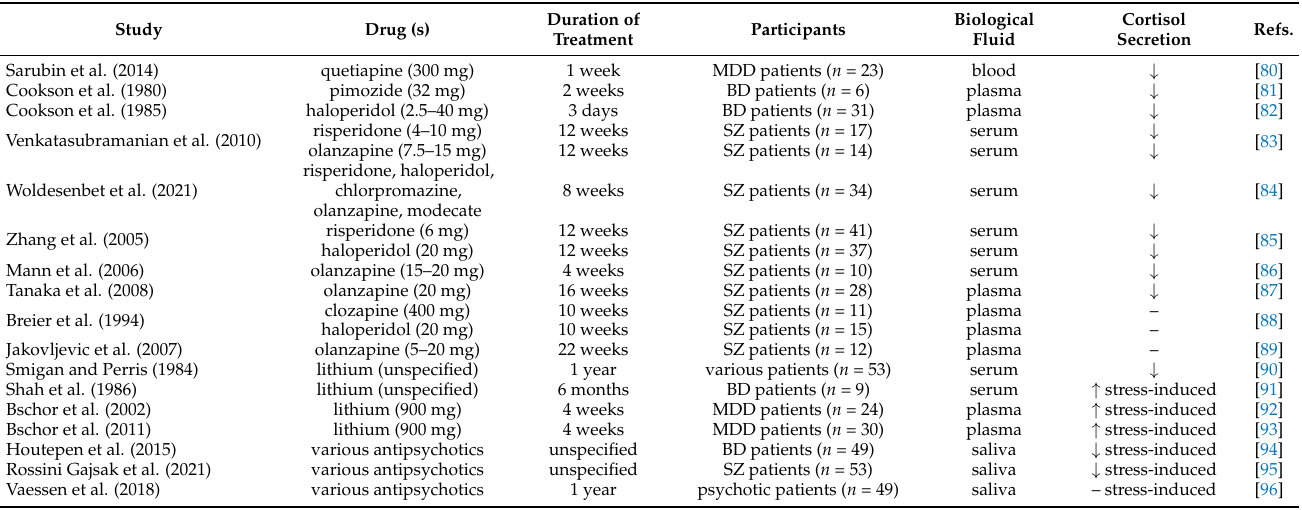
Table 2. Summary of findings from studies investigating changes in cortisol concentrations following antipsychotic drug treatment in